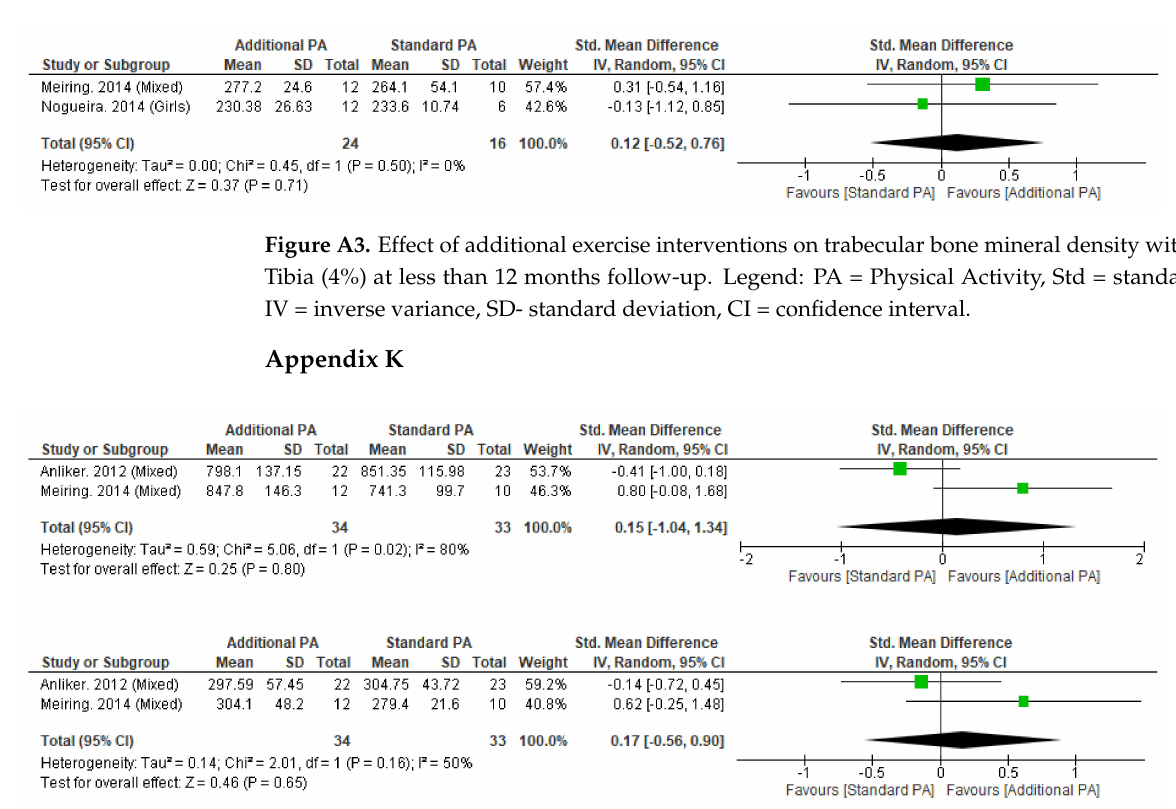
Figure A4. Effect of Additional Exercise Interventions on bone cross-sectional area at less than 12 months follow-up measures. ( Top ) 4% Tibia, ( Bottom ) 38%Tibia. Legend: PA = Physical Activity, Std = standardised, IV = inverse variance, SD- standard deviation, CI = confidence interval.